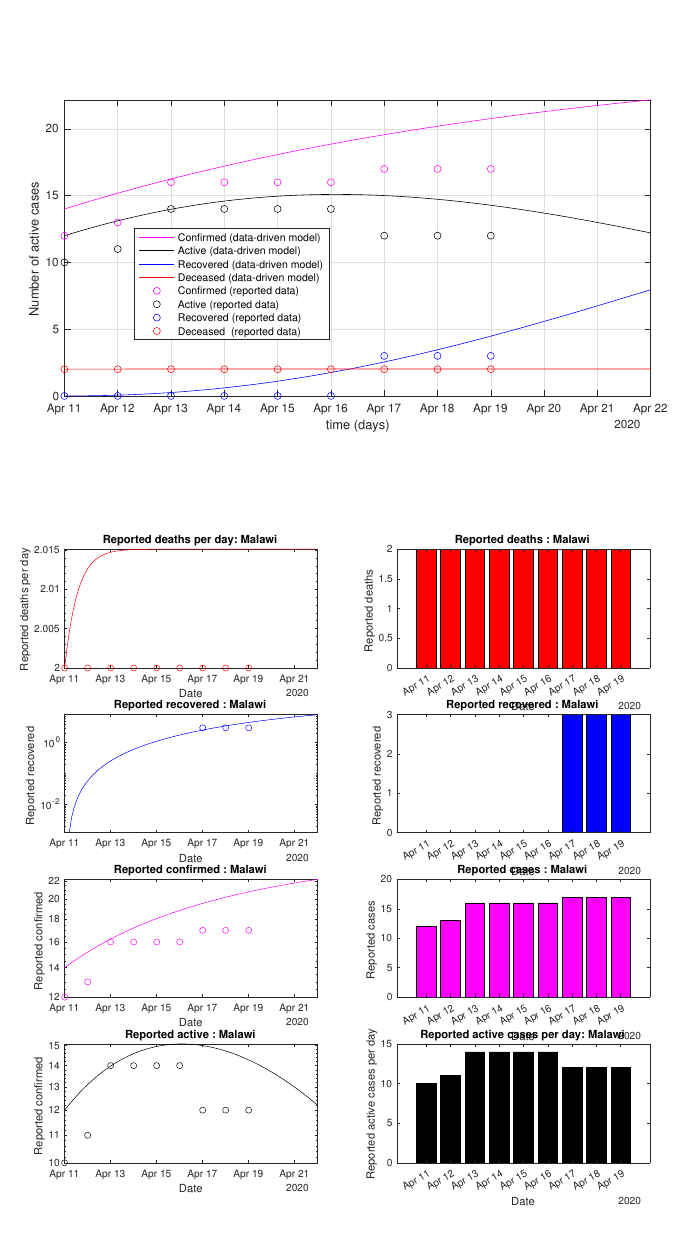
Figure 71. Malawi: data vs.